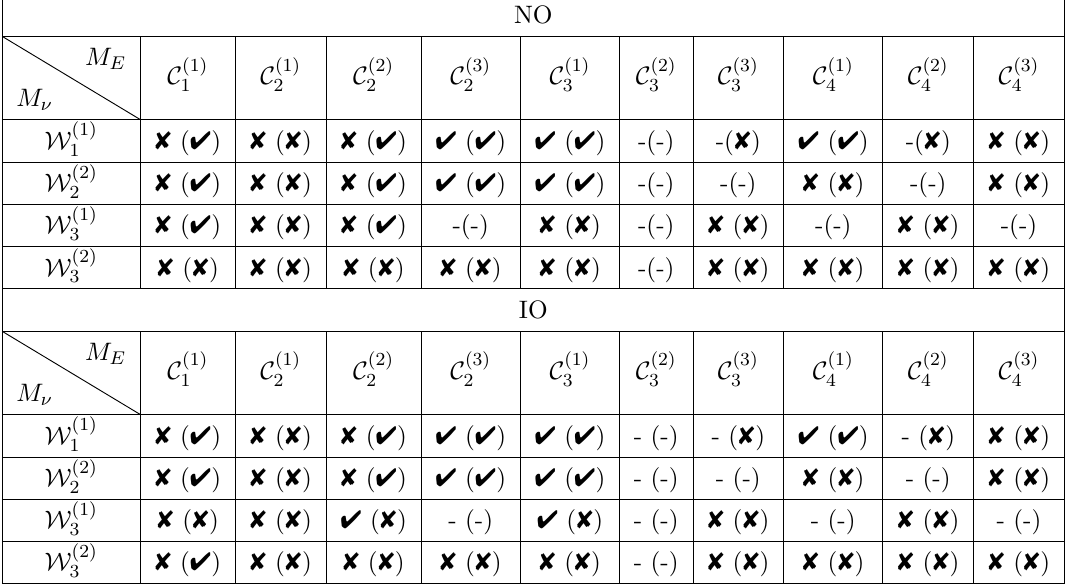
Table 10. Same analysis as in tables 8 and 9 but now for a Majorana neutrino mass matrix M ν generated via the Weinberg operator — see table 4 for the general structure of the W textures. The results for NO (IO) are shown in the upper (lower) part of the